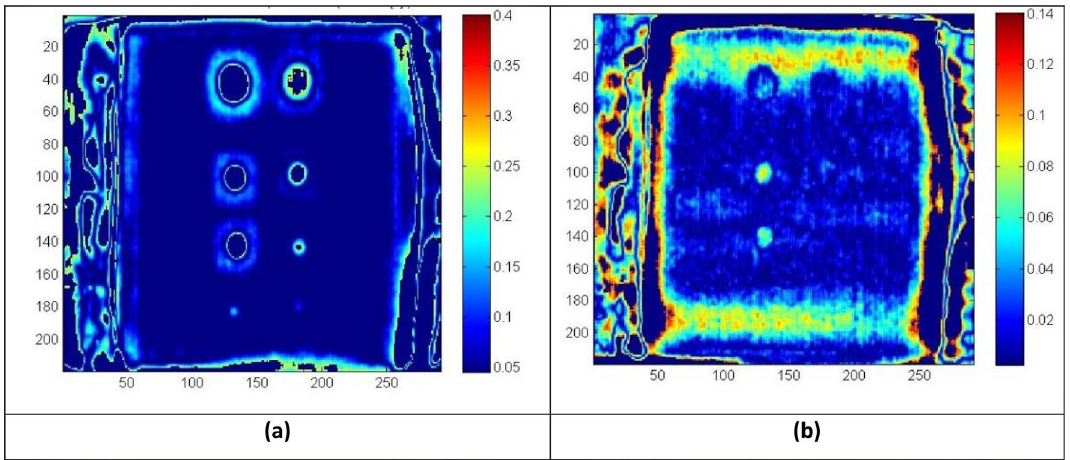
Fig. 6 Contrast map for defects detection in a traditional thermography (heating for 3 s) and b SMArt thermography (heating for 240